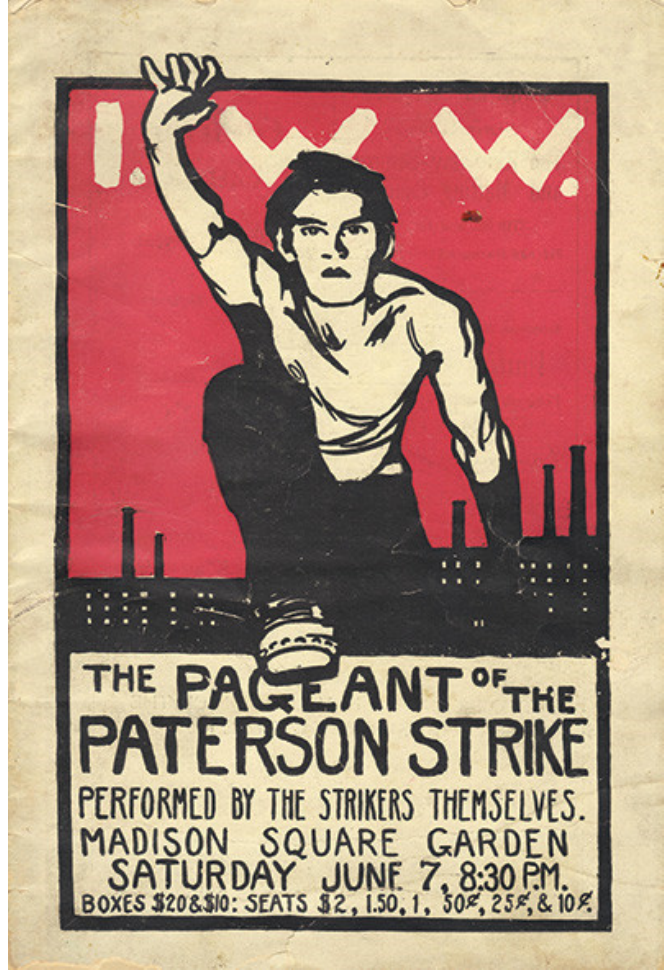
Figure 7. IWW poster for Paterson Strike Pageant, 1913. Designed by Robert Edward Jones. Wikicommons.